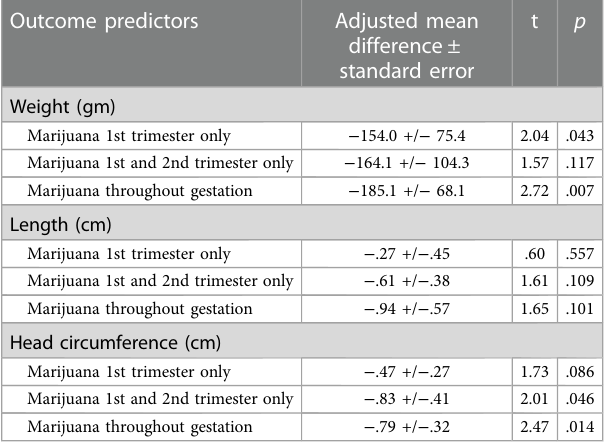
TABLE 2 Regression results predicting birth size from timing of marijuana exposure. Outcome